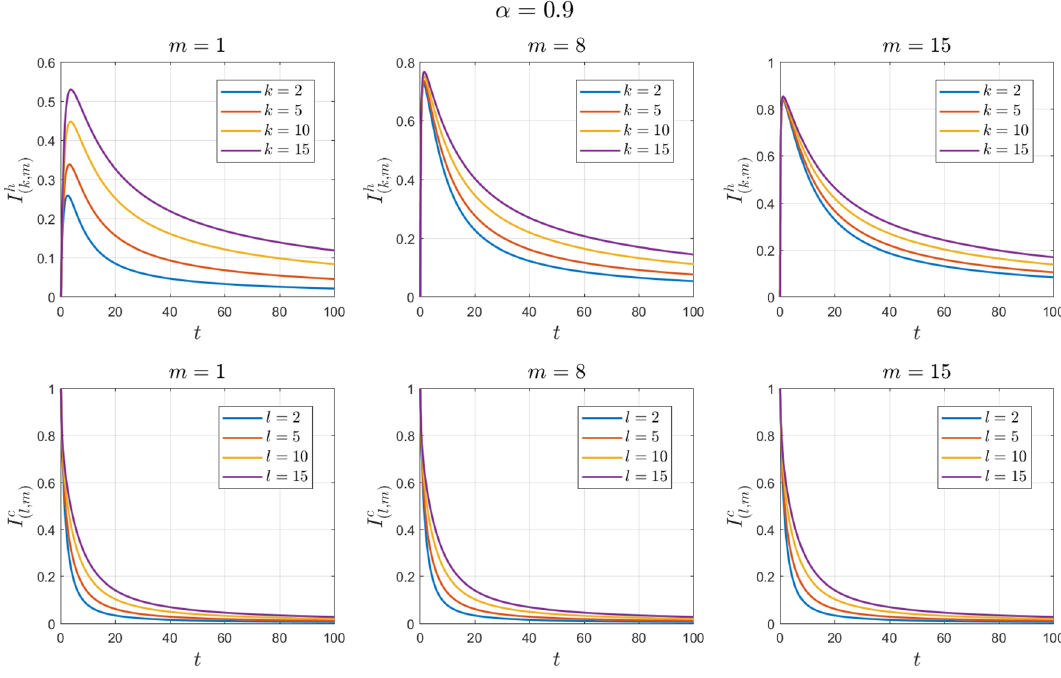
= ( 0 ) , I h ( 0 ) , S c ( 0 ) , I c ( 0 ) S h ( k , m ) ( k , m ) ( l , m ) ( l , m ) (cid:31) (cid:30)